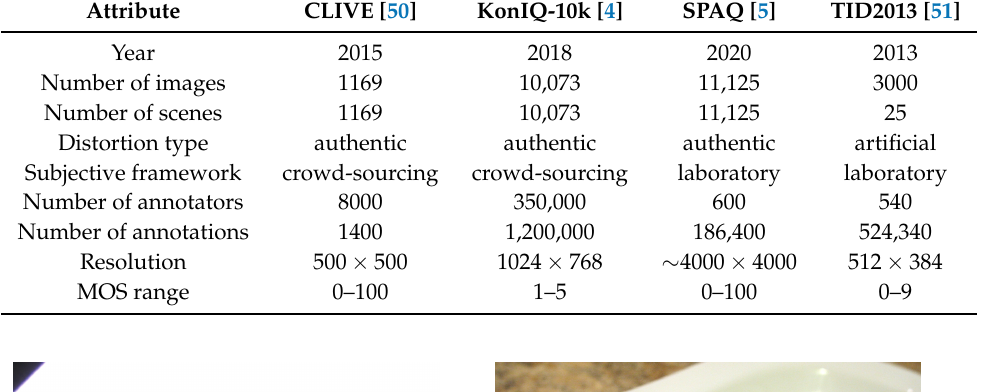
Table 1. Overview about the applied publicly available IQA benchmark databases. In this table, we denoted by ’-’, if the data is not available.